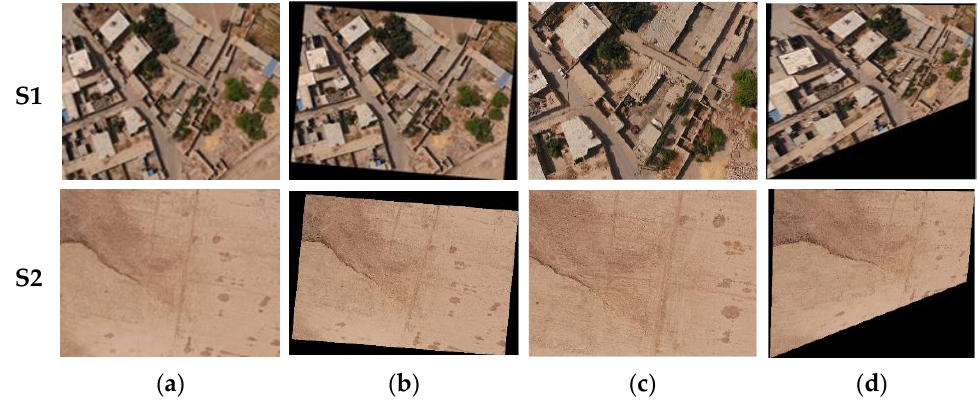
Figure 4. The employed synthetic image dataset with different transformations: ( a ) original image, ( b )rotation, ( c ) scale, ( d )viewpoint transformations. Three UAV image blocks were used in the real image network dataset. The selected images were captured by low-cost aircraft and cover both urban and rural areas with different patterns of texture. Datasets are characterized by different image resolution, the number of images, the overlap of images, changes in illumination and surfaces with different textures and sizes. Figure 5 shows the datasets used with their sample images and camera networks, and Table 2 summarizes their